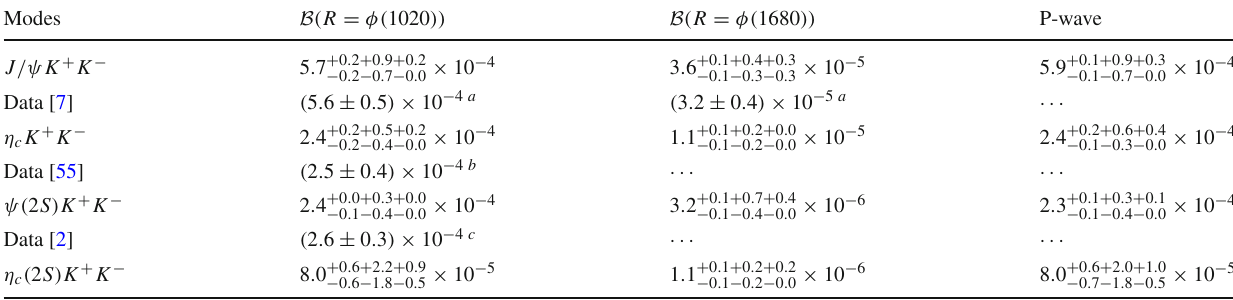
Table 3 Branching ratios of P -wave resonance contributions to the B